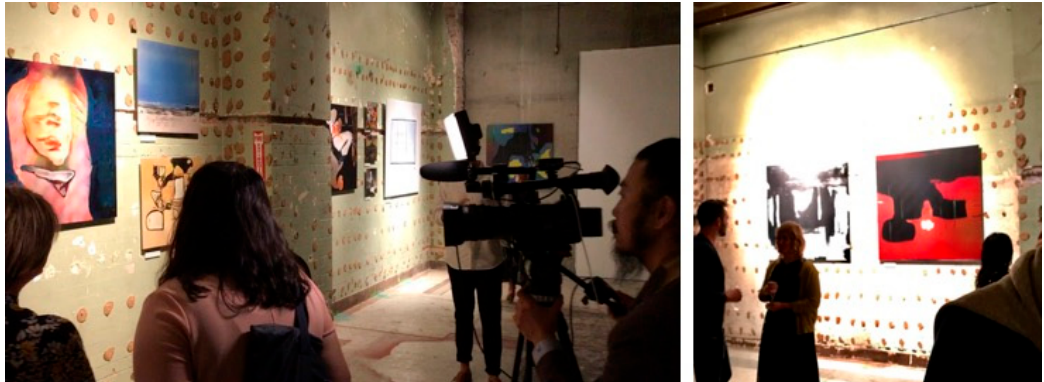
Figure 5. Photographs from AICAN exhibition held in Los Angeles in October 2017. Photographs by author A.